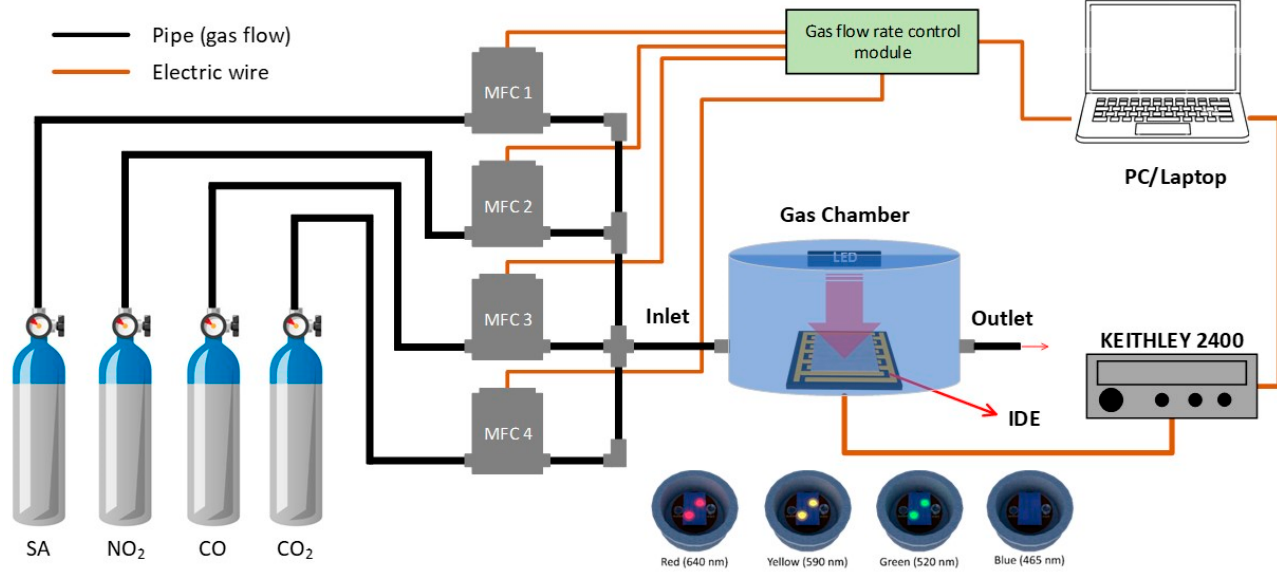
Figure 2. Schematic of the measurement system for light-activated gas sensing response.